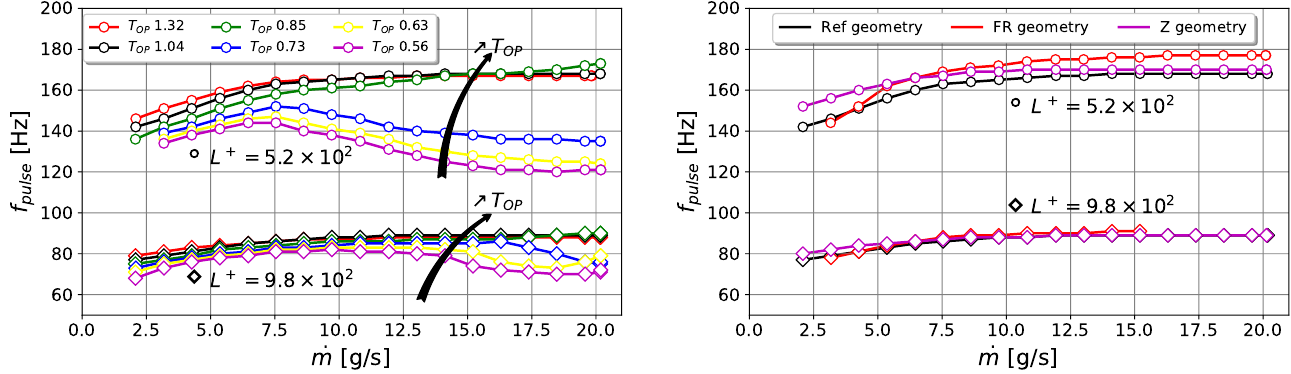
Figure 14. Variation of throttling ratio using the reference geometry ( left ) and variation of settling chamber geometry with a constant throttling ratio of T OP = 1 and feedback loop diameter D + = 1.82 ( right